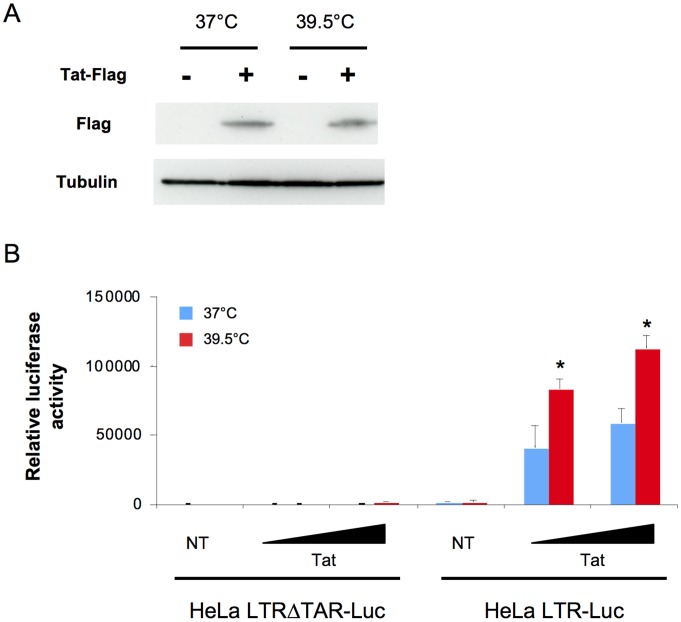
Hyperthermia enhances Tat-dependent LTR transcription.A: Levels of Tat in HeLa-LTR-Luc cells. Cells were transfected with 20 ng of Tat-Flag. After 4 hours at 37°C, cells were washed and grown at 37°C or 39.5°C for 48 hours. Tat-Flag and tubulin levels were assessed by Western Blot. B: LTR activity in HeLa cells at 37°C or 39.5°C. HeLa-LTR-Luc and HeLa-LTRΔTAR-Luc cells were transfected with 4 ng or 20 ng of Tat-Flag. After 4 hours at 37°C, cells were washed and grown at 37°C or 39.5°C. 48 hours later, luciferase levels were measured and normalized to protein concentration. Data are mean ± SD of 3 independent experiments. Statistical significance was assessed by the Mann-Withney test. p<0.05(*).